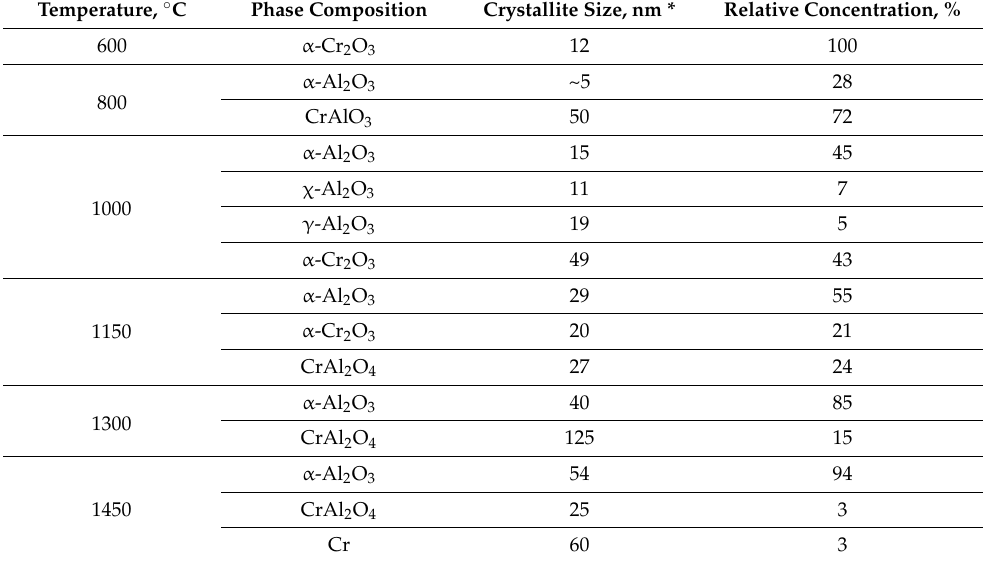
Table 3. Phase composition of the investigated samples during reduction at different temperatures. Temperature, ◦ C Phase